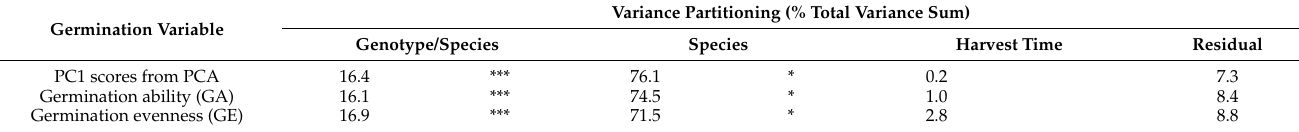
Asterisks denote that a factor is significant within each variable ( p value = *** < 0.001; * <